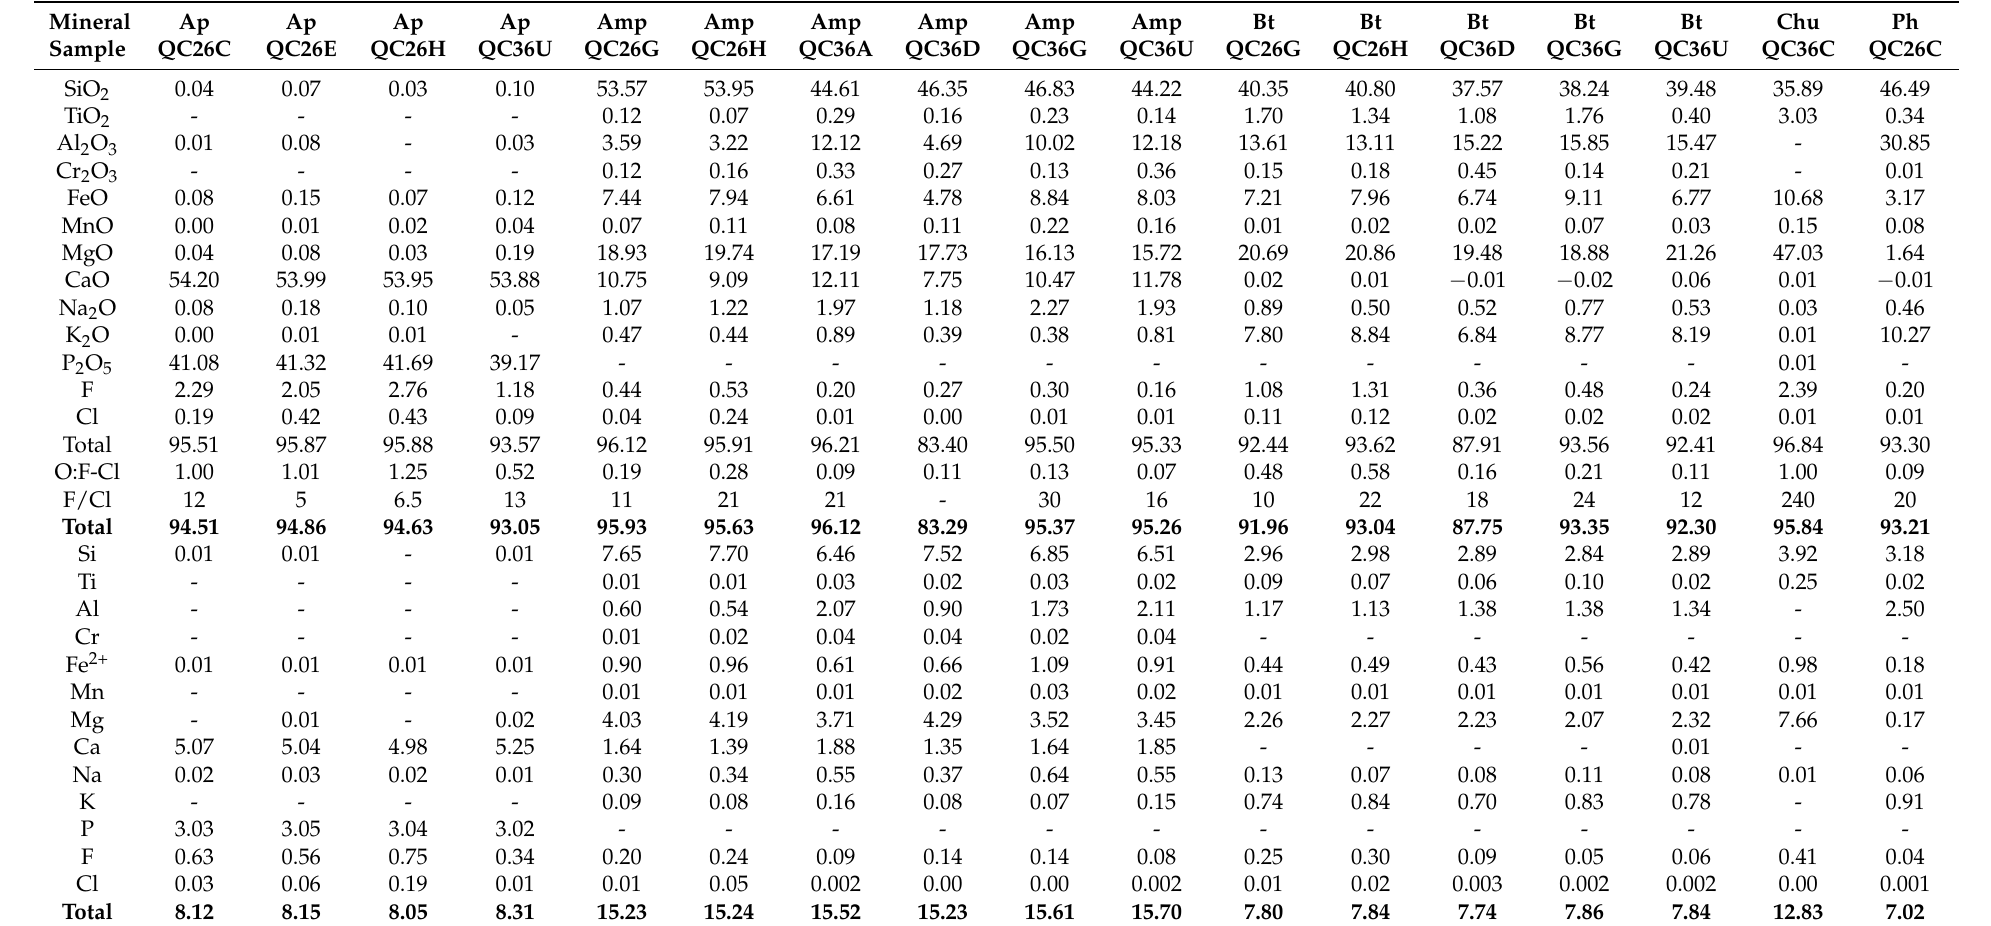
Table 3. Hydrous mineral compositions obtained by